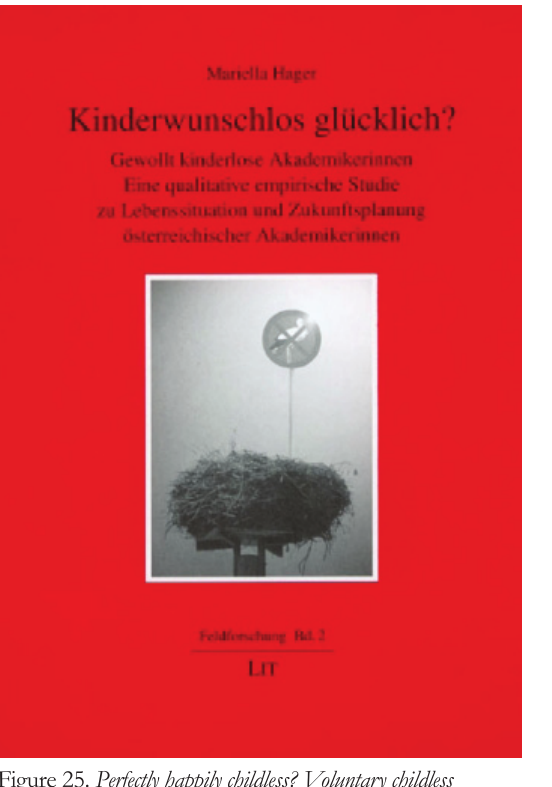
Figure 25. Perfectly happily childless? Voluntary childless graduates. A qualitative empirical study of the life situation and future plans of female Austrian graduates (2006) used with kind permission of Moritz Cordon.